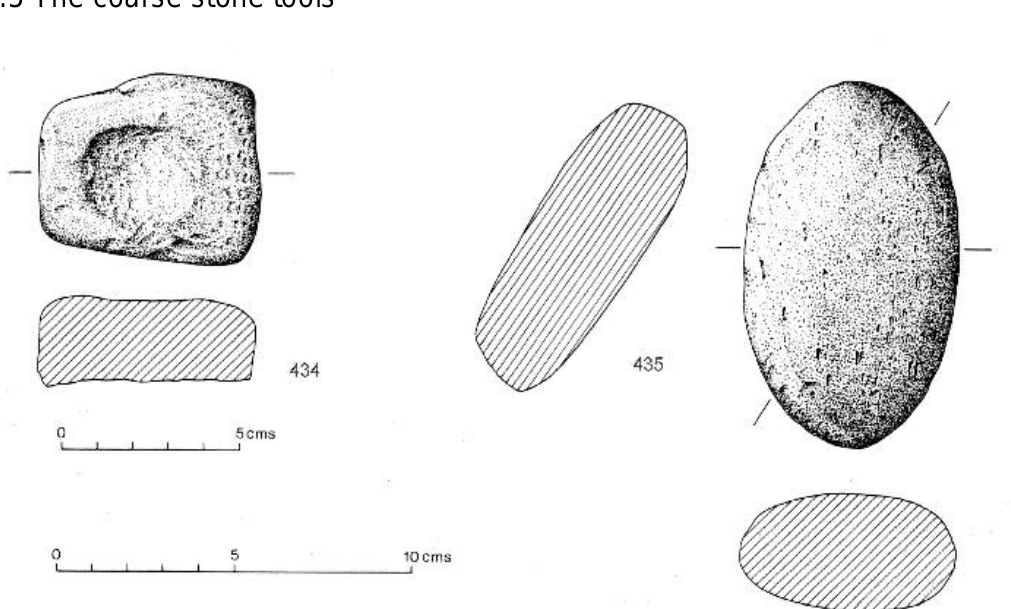
Figure 9: The coarse stone tools: 434 the hollowed stone; 435 the faceted